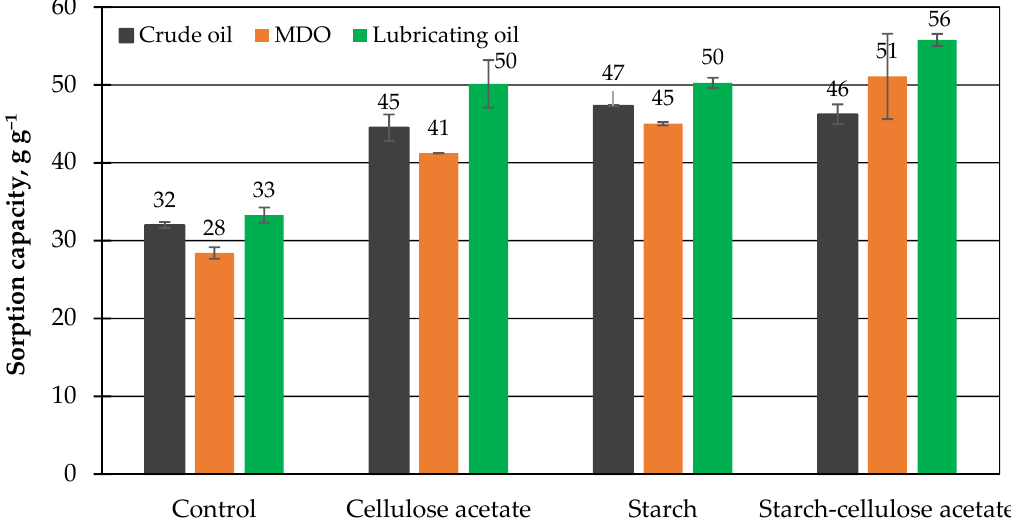
Figure 6. Results of aerogels sorption capacity to crude oil, MDO and lubricating oil.